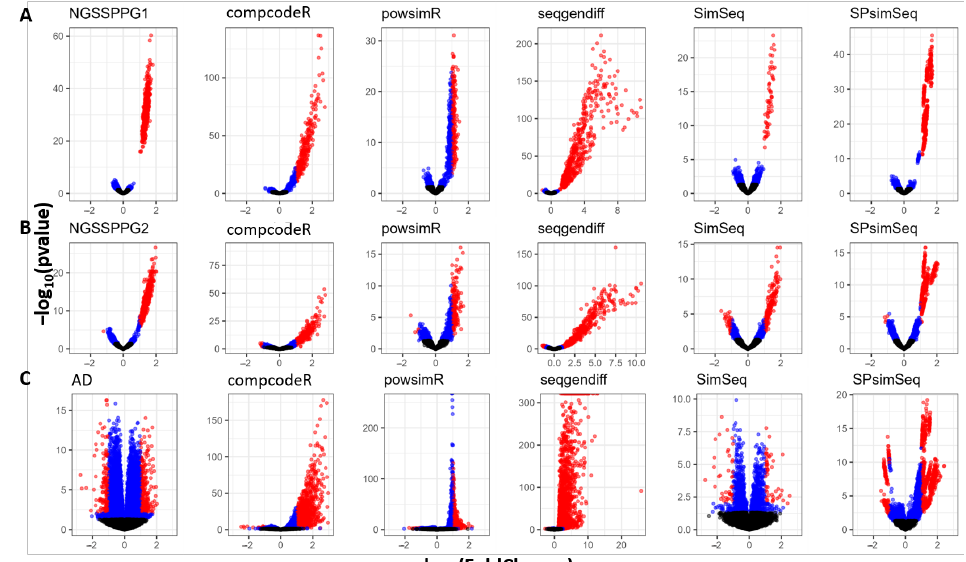
Figure 7. Volcano plots for: ( A ) NGSSPPG1; ( B ) NGSSPPG2; and ( C ) AD datasets and the datasets generated with these as input. Blue dots: transcripts with p -value > 0.05, denoting significant differential expression. Red dots: transcripts with p -value > 0.05 and log 2 ( FoldChange ) > 1 or with p -value > 0.05 and log 2 ( FoldChange ) < −